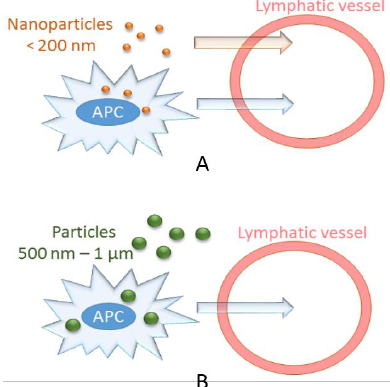
Figure 2. The size of the particle affects its entry into the initial lymphatic vessel. ( A ) Particles smaller than 200 nm in diameter can efficiently enter the lymphatic system either freely or are transported by antigen presenting cells (APCs); ( B ) Particles larger than 500 nm require active transport by APCs to the lymph nodes.